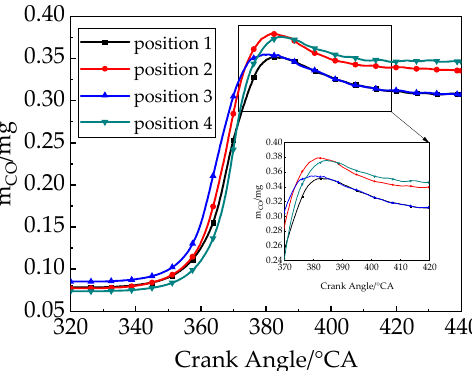
Figure 14. CO emission changes at different positions.